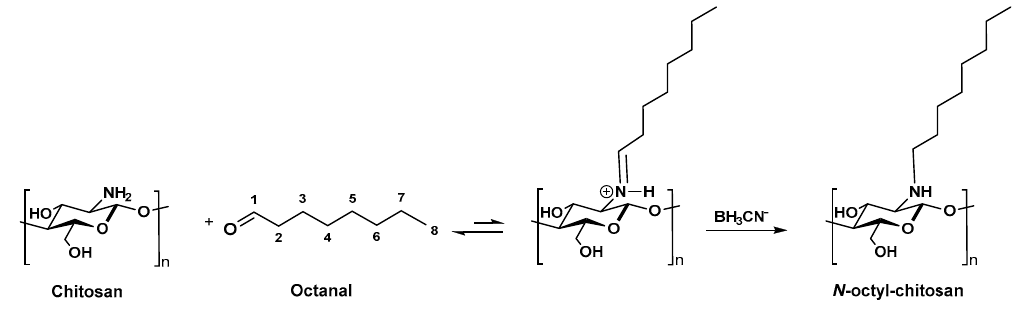
Figure 3. Synthesis of N -octyl-chitosan by alkylation process.